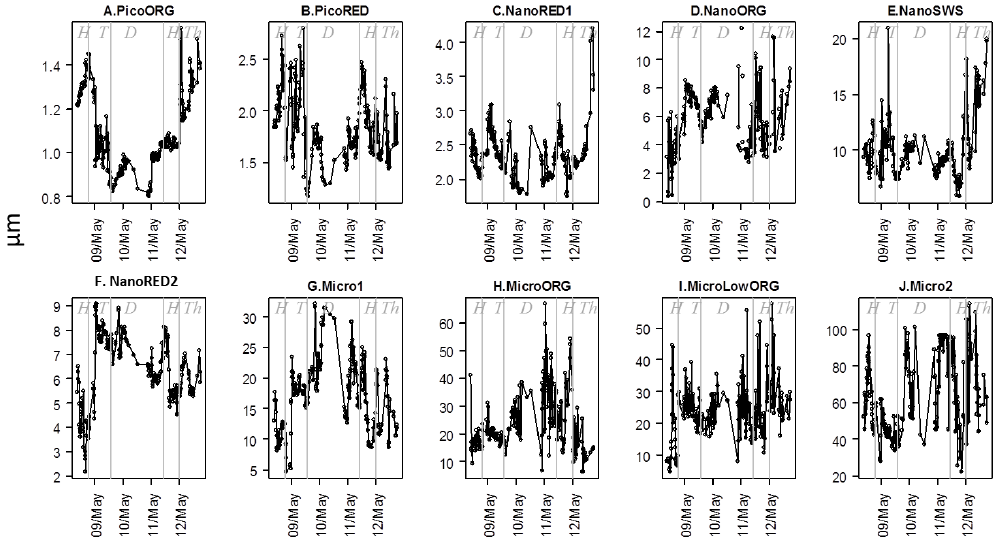
Figure 6. Average estimated size for each phytoplankton cluster resolved with the scanning flow cytometer. In order to show evidence of distribution, scales have not been homogenized. Grey bars separate the traversed marine areas: H, Humber; T, Tyne; D, Dogger; Th, Thames.